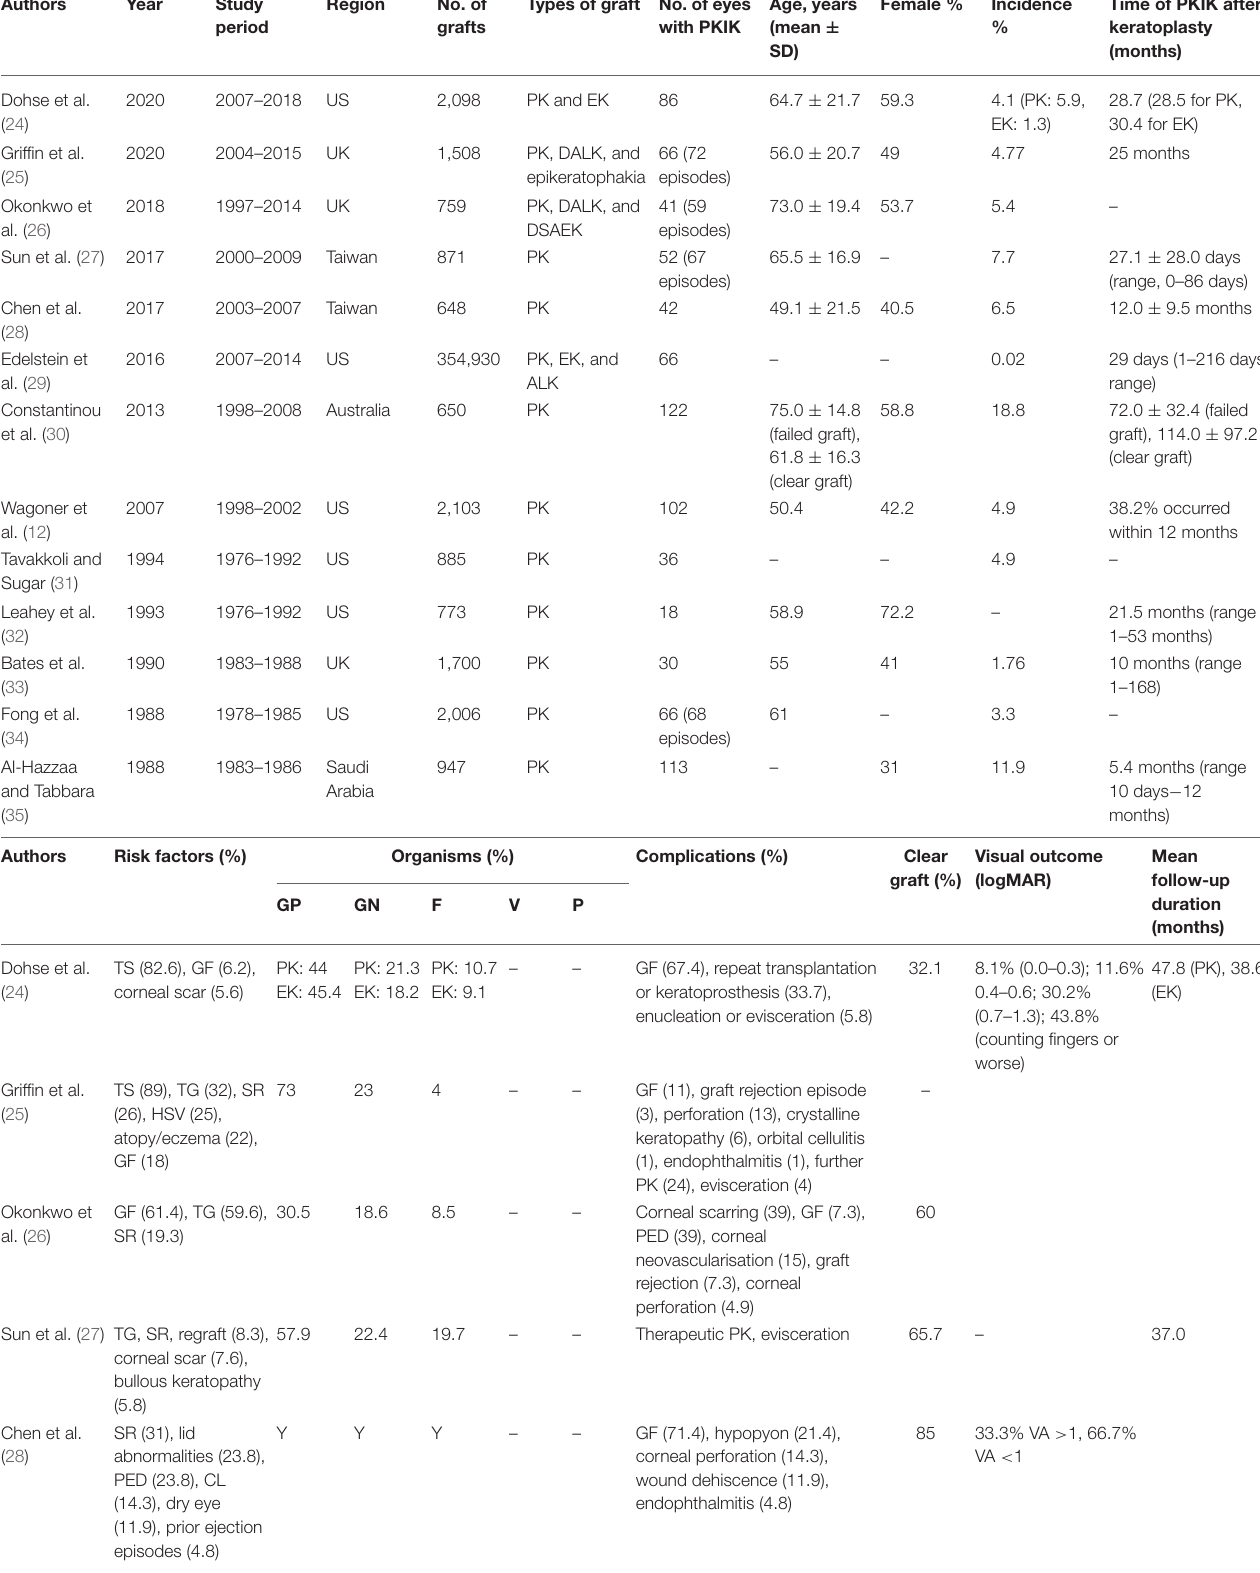
TABLE 1 | Summary of post-keratoplasty infectious keratitis (PKIK) based on large case studies ( > 500 cases), in the order of